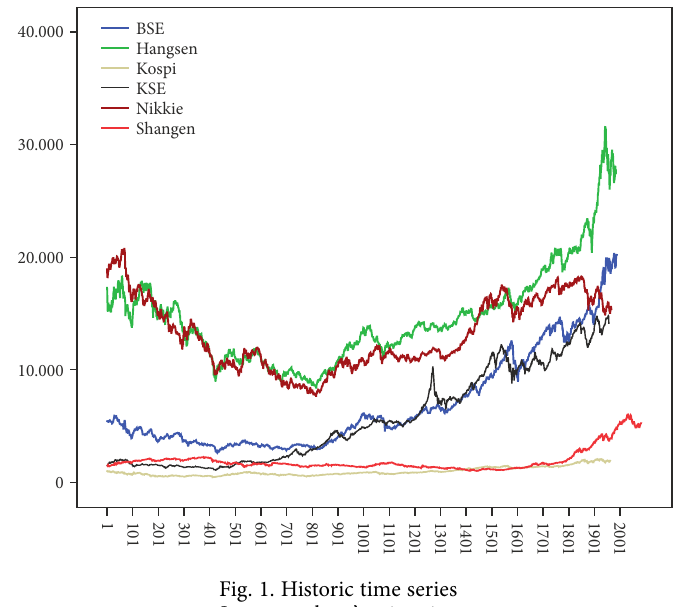
Fig. 1. Historic time series Source: authors’